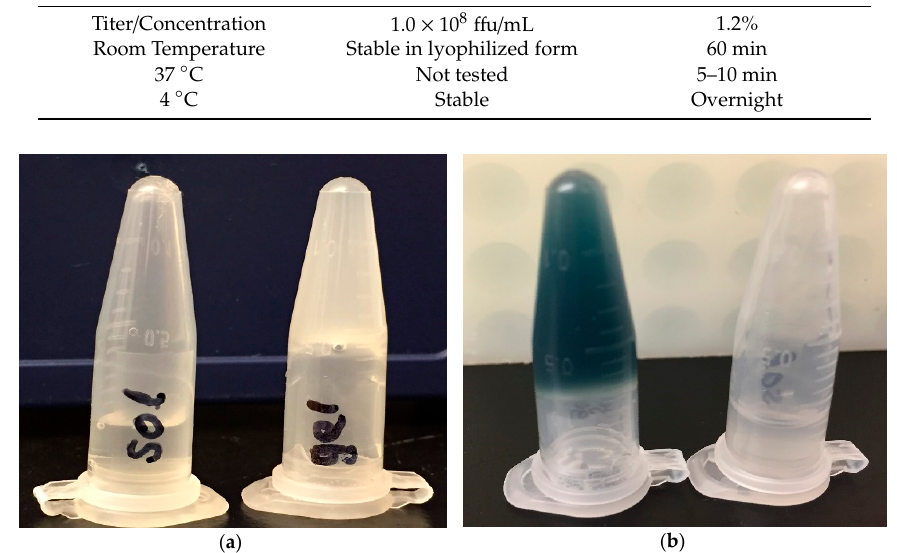
Figure 1. Gelling study of the ERA-2GnRH hydrogel vaccine. ( a ) Tube 1 is the ERA-2GnRH hydrogel at room temperature; the gel is liquid and settles down to the bottom. Tube 2 is the hydrogel vaccine incubated at 37 °C for 10 min. ( b ) Tube 1 is the hydrogel vaccine with a blue dye (0.01% Ivan’s blue) incubated at 37 °C for 10 min. Tube 2 is the room temperature product, a liquid gel.